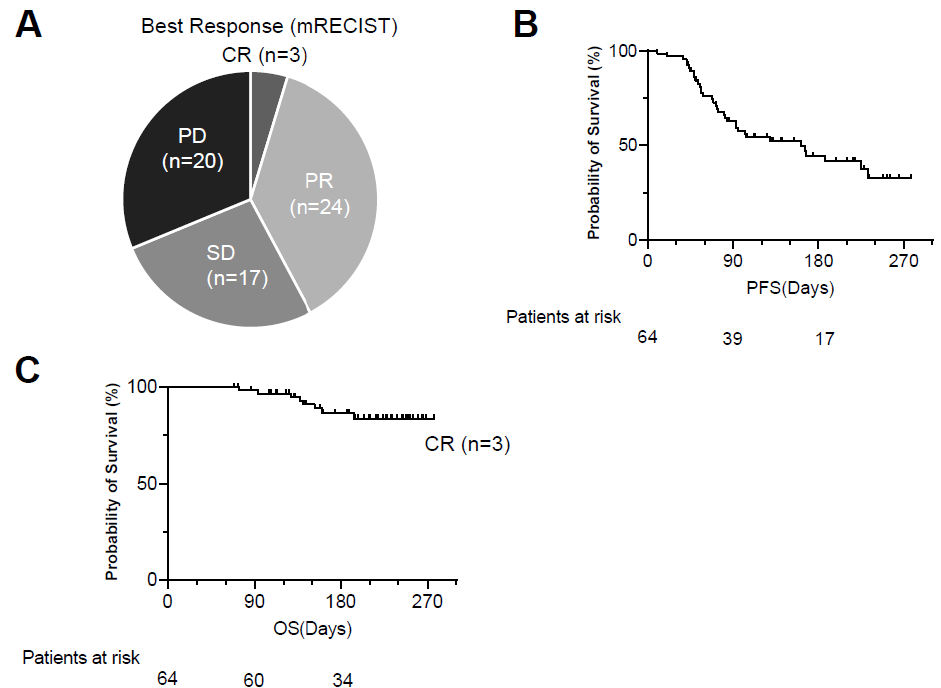
Figure 3. Treatment response to Atezo/Bev therapy. ( A ) The best response to Atezo/Bev was evaluated by mRECIST. ( B , C ) Kaplan–Meier curves of progression-free survival (PFS) ( B ) and overall survival (OS) ( C ). Atezo/Bev, Atezolizumab and bevacizumab; CR, complete response; PR, partial response; SD, stable disease; PD, progressing disease.